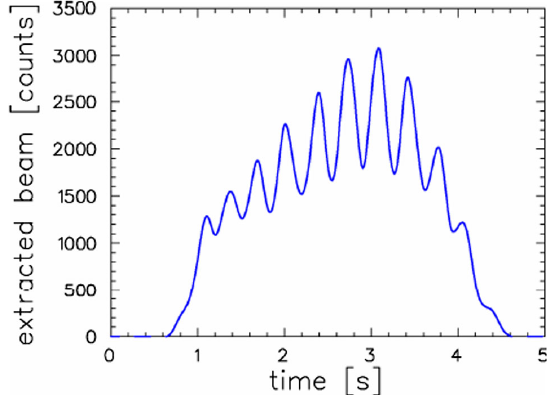
FIG. 6. Spills obtained for Ar 18 þ beam at beam energy E ¼ 500 MeV = u bunched with the rf voltage of harmonic ¼ 12 kV with varied horizontal number h ¼ 5 and amplitude V rf emittance and momentum width. The black curve corresponds to the solid black curve in Fig. 5, where the initial horizontal tune is ¼ 4 . 329 in the figure above to Q ¼ 4 . 327 changed from Q x; x; ini ini in this figure in order to enable the application of increased horizontal emittance and momentum